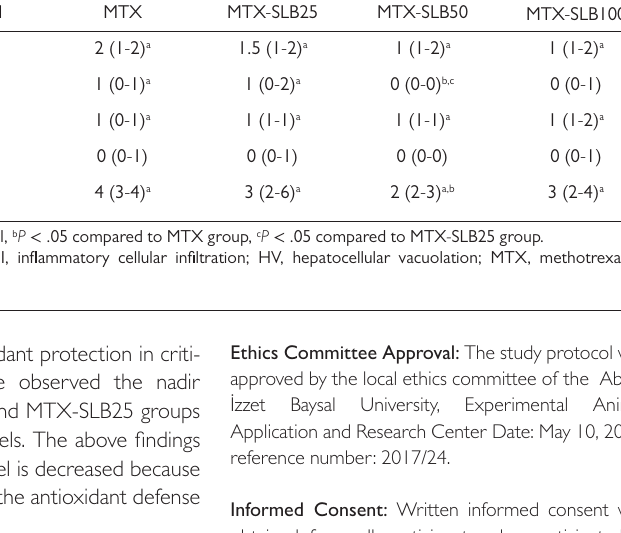
Table 5. Sinusoidal Dilatation (SD), Inflammatory Cellular Infiltration (ICI), Hepatocellular Vacuolation (HV), and Necrosis Scores [Median